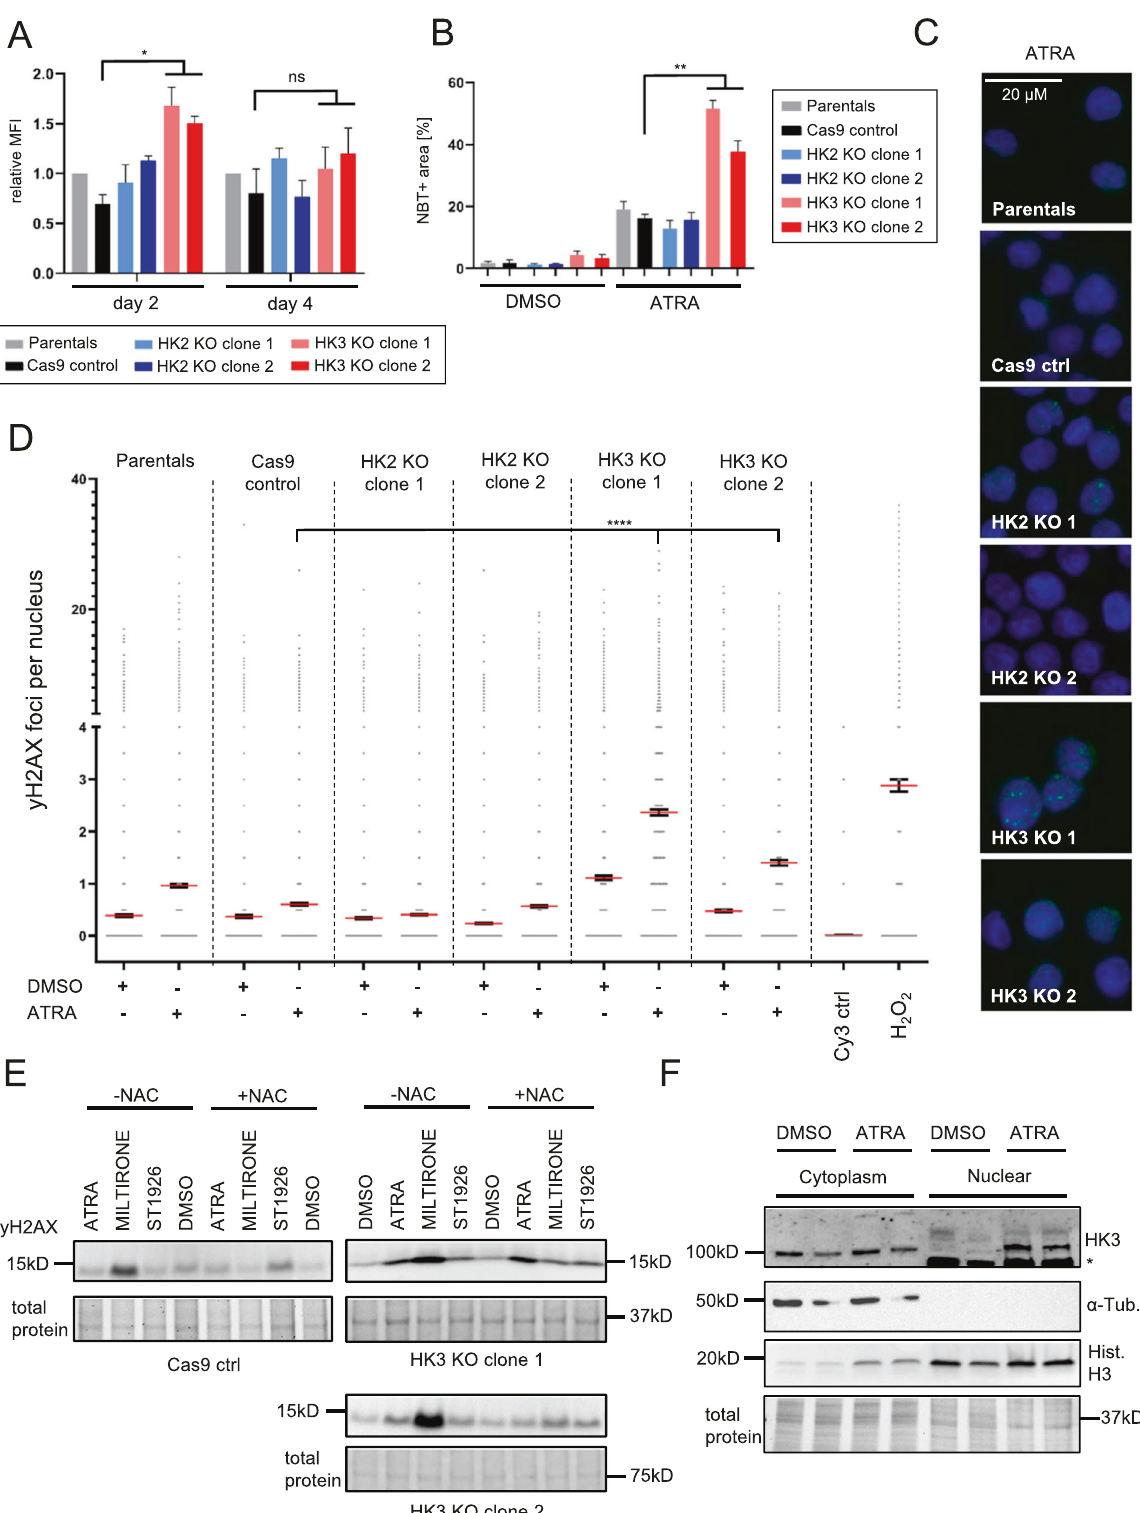
Fig. 4 Loss of HK3 increases ROS and was correlated with DNA damage. A Relative MFI of CM-H2DCFDA staining in HL60 cell lines on day 2 and 4 of ATRA treatment ( n = 2, 2 technical replicates each, mean ± SEM). B NBT positive cell area after 4 days of ATRA treatment in HL60 cell lines ( n = 2, 2 technical replicates each, mean ± SEM). C Representative pictures of nuclear yH2AX foci in HL60 cell lines after 3 days of ATRA treatment ( n = 2). D Quanti fi cation of nuclear yH2AX foci measured on an InCell microscope in HL60 cell lines ±3 days of ATRA treatment ( n = 2, 500 nuclei/well, ≥ 2 wells per condition, mean ± SEM). E Western Blot analysis of yH2AX levels in HL60 control and HK3 -null cell clones upon 24 h of indicated treatments. NAC samples were preincubated in 3 mM NAC for 2 h prior to adding treatments. F Nuclear fractionation of HL60 cell line ±4 days of ATRA treatment. *unspeci fi c band at ~80 kDa. Mann – Whitney U : * p < 0.05, ** p < 0.01, **** p < 0.0001.